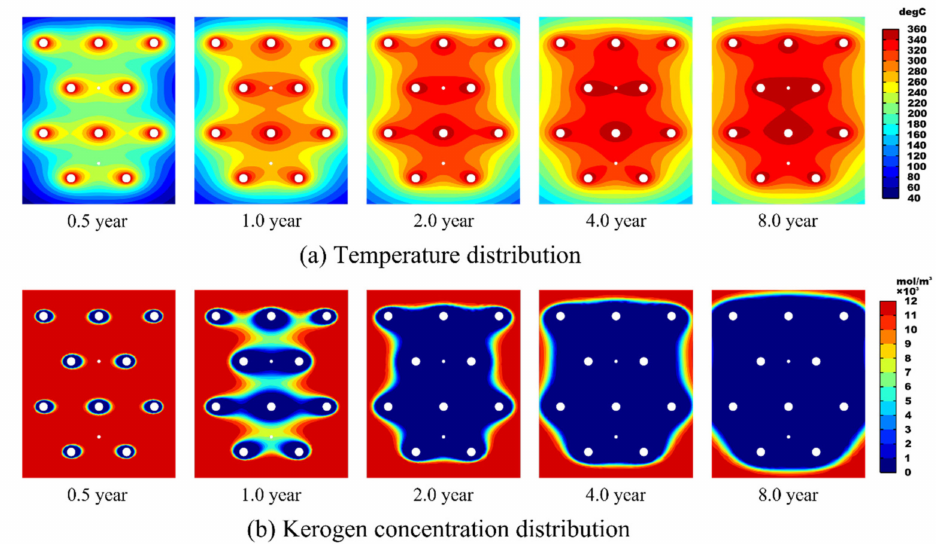
Figure 3. Temperature and kerogen concentration distribution during the in situ conversion process: